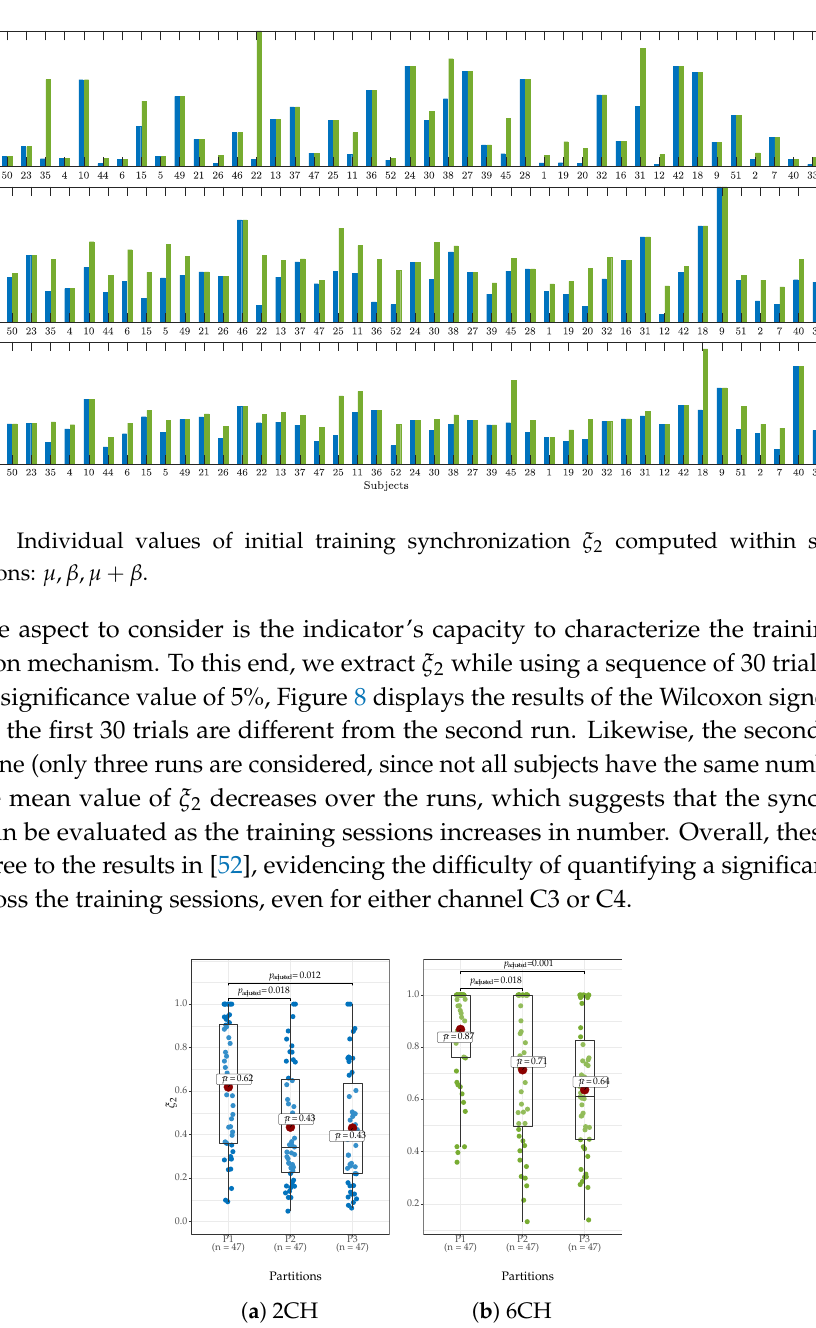
Figure 8. Differences in initial training synchronization ξ 2 performed at each trial partition during the training